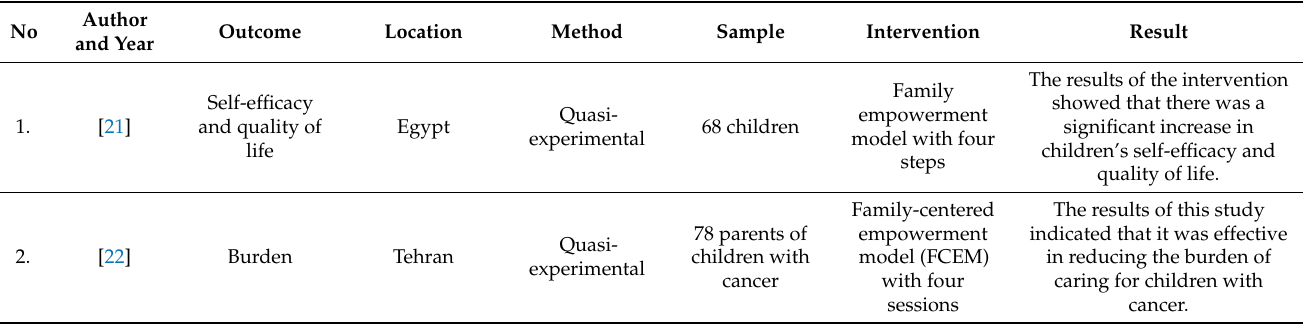
Table 2. Extraction